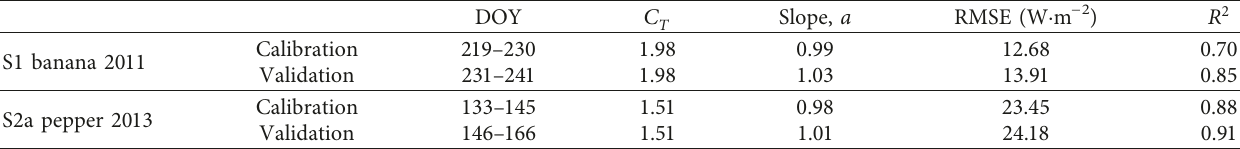
Table 5: Statistical variables and C